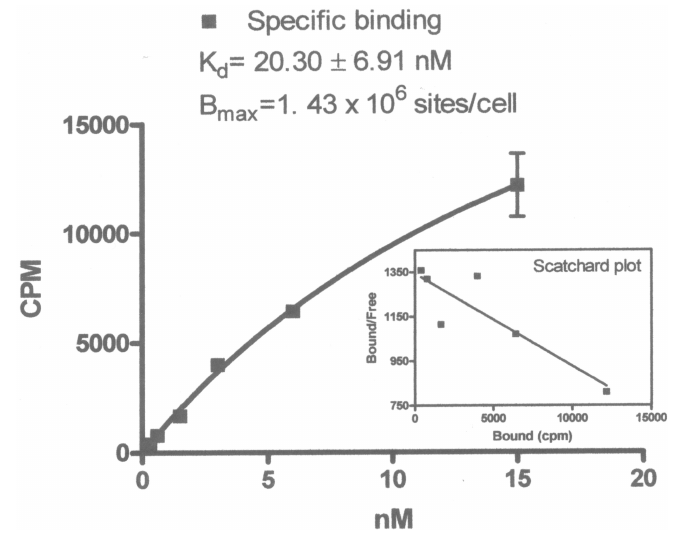
Figure 4. Dissociation constant data (Kd) for 149 Pm-DOTA-PEI-Trastuzumab with human breast adenocarcinoma SkBr-3 cells ( n = 3).